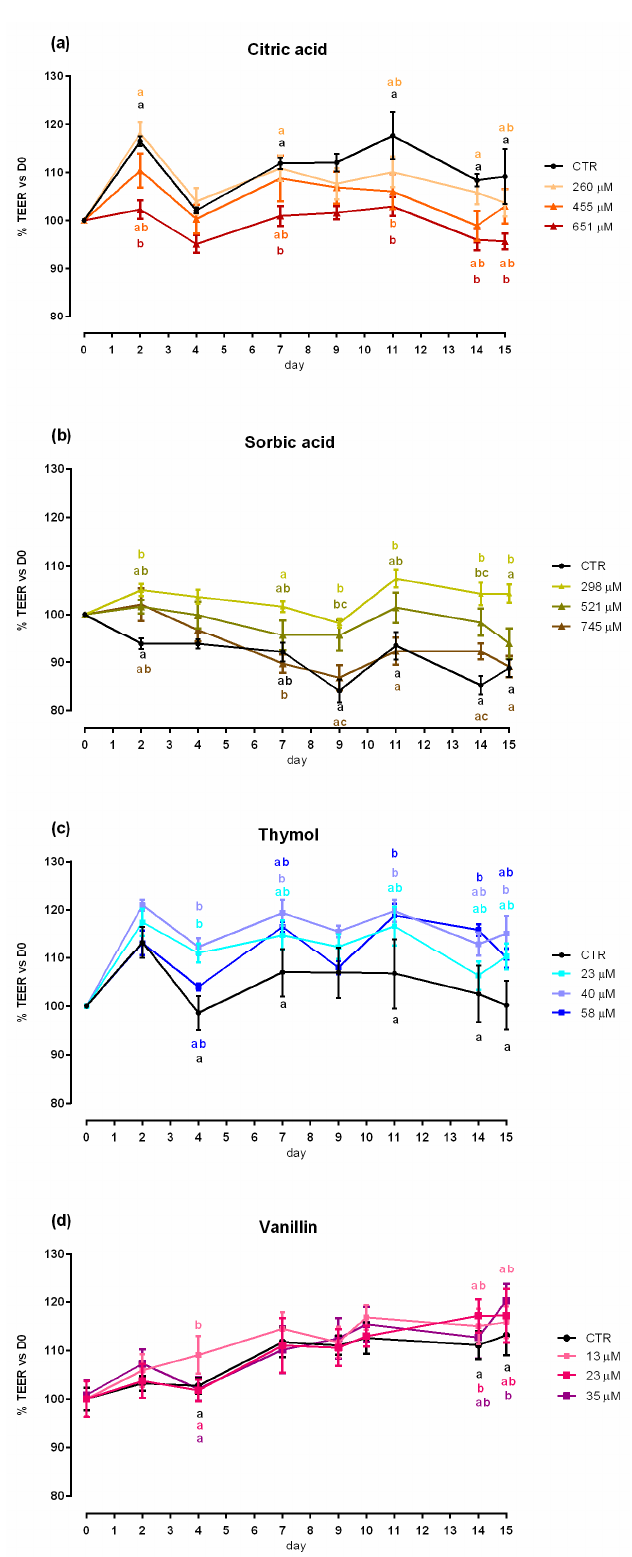
Figure 1. TEER of Caco-2 cells cultured with single OA and NIC. Data in the graph are represented as percentage over the initial TEER value and given as means ( n = 6) ± SEM, represented by vertical bars. Means with di ff erent letters indicate statistical significance with p < 0.05 (a, b); means with at least